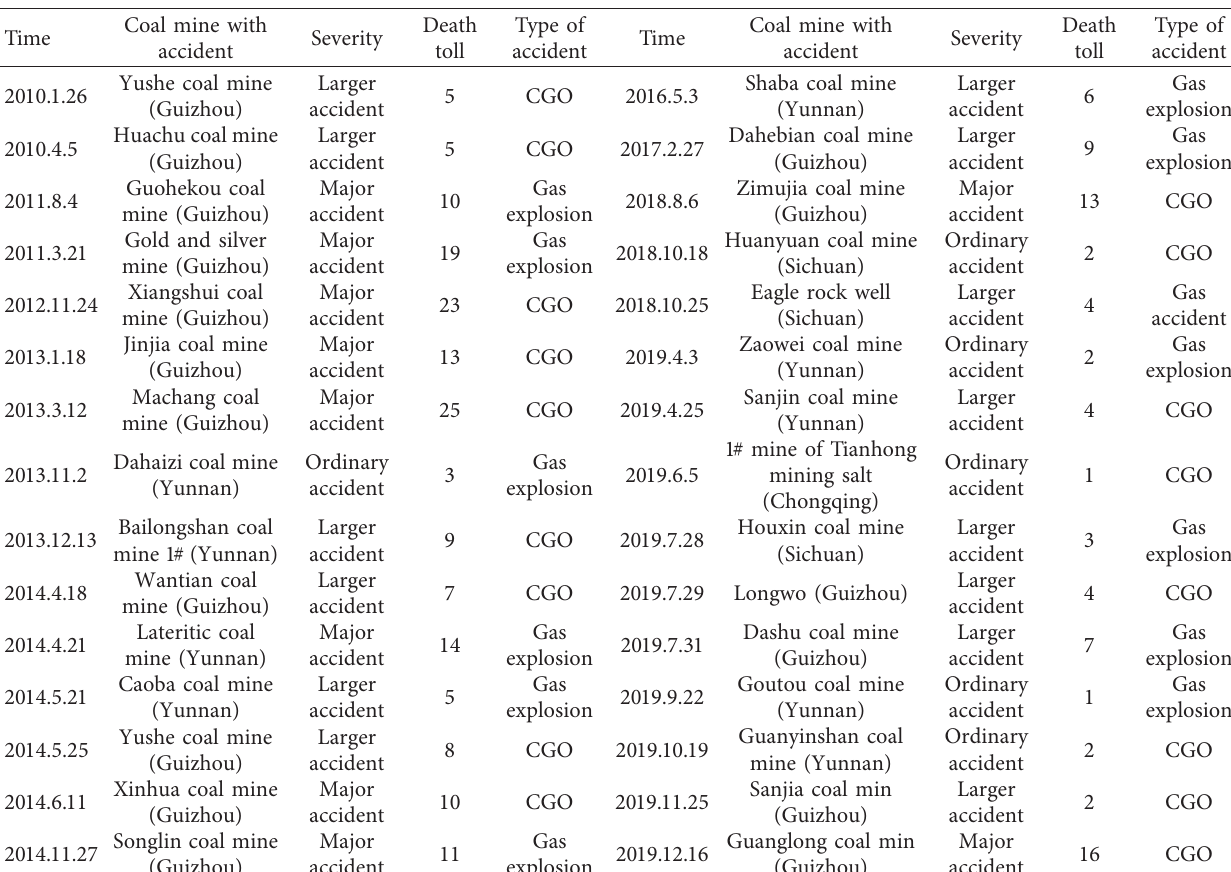
Table 1: Some gas accidents in YGC.